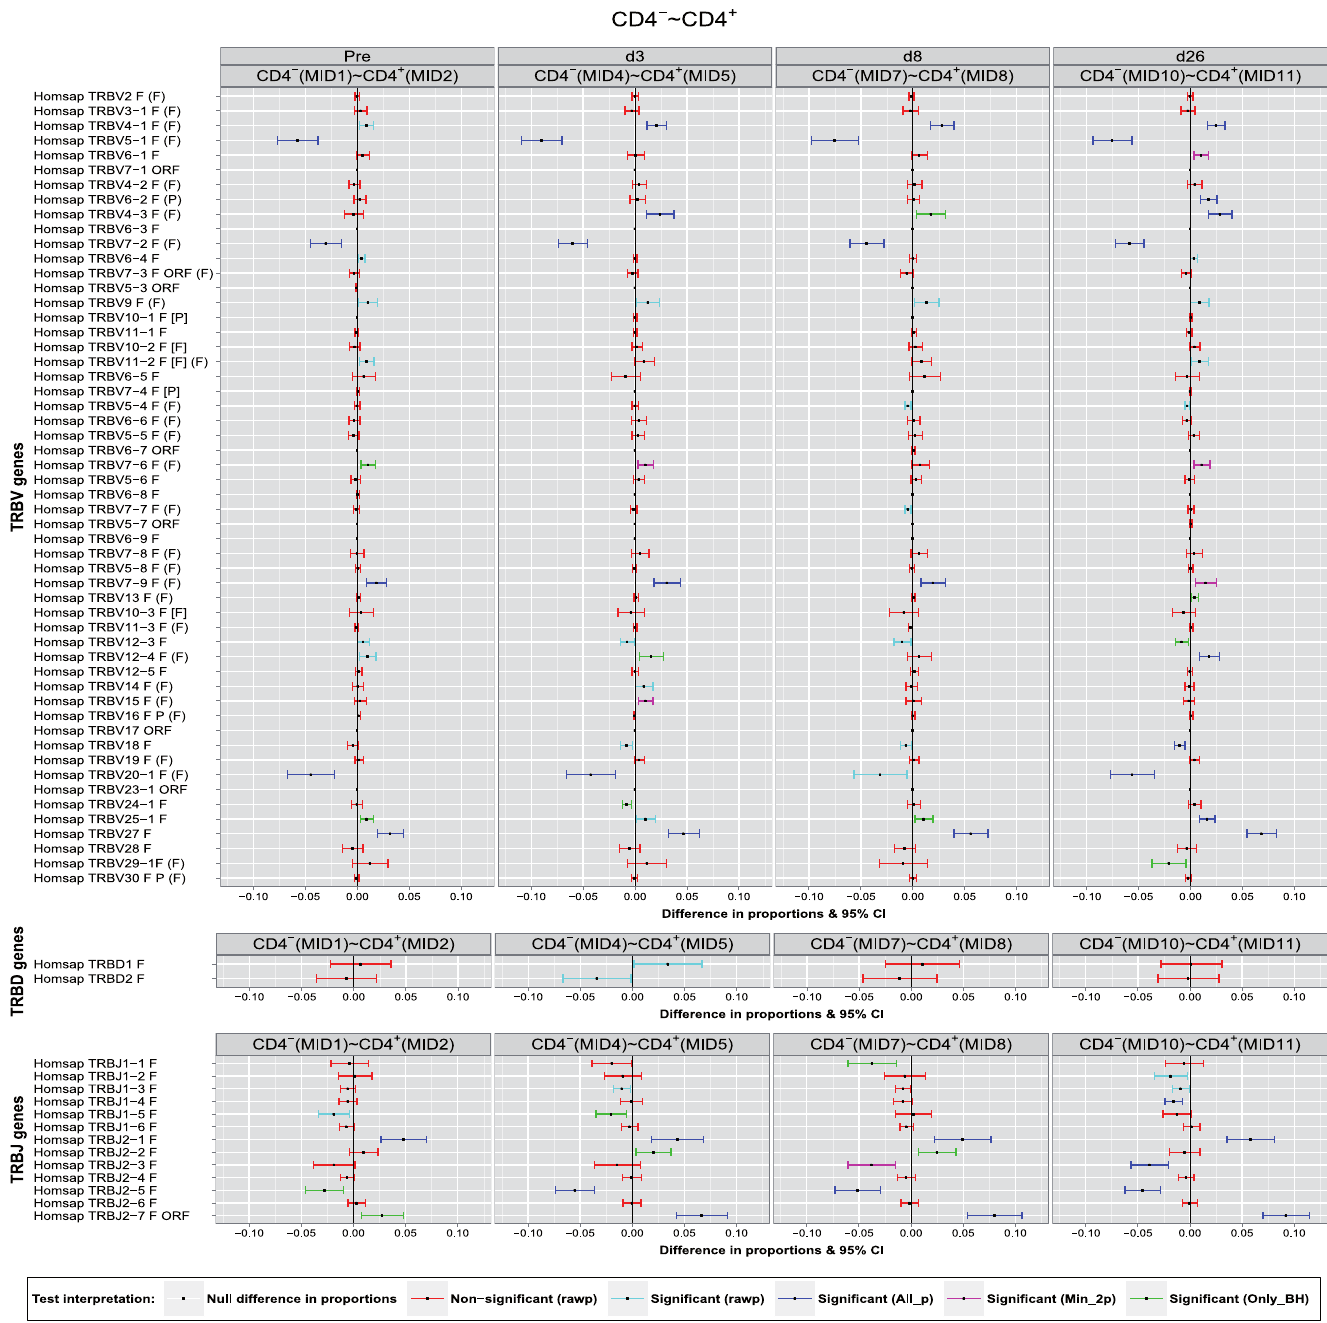
Fig 3. Differences in proportions graph. The difference in proportions graph with significance and confidence interval (CI) bars are shown for Homo sapiens TRB IMGT clonotypes (AA) with a gene of a given group (TRBV, TRBD or TRBJ) between two T cell populations (CD4 - and CD4 + ) at four time points (Pre, d3, d8 and d26). Negative differences in proportions ( p {CD4 − } - p {CD4 + } < 0) are shown on the left of the vertical line (abscissa equal to 0) and positive differences ( p {CD4 − } - p {CD4 + } > 0) are shown on the right of the vertical line. CI bars colors indicated in the legend correspond to the test interpretation before adjustment of p -values (rawp) (significant differences validated by the seven procedures (All_p): dark blue, by two or more multiple testing procedures (Min_2p): pink, and only by BH (Only_BH): green).